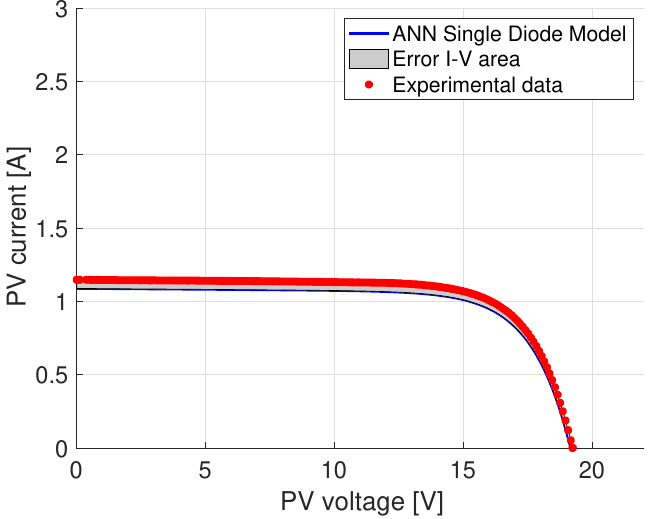
Figure 11. Comparison of experimental data and reconstructed single-diode I - V curve with estimated ANN parameters in healthy condition. In this case, the error area is 5%.